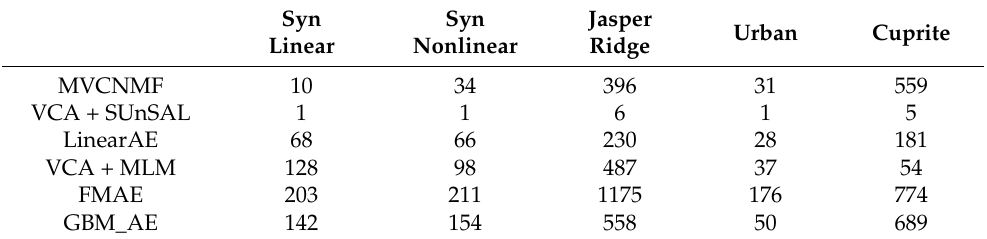
Table 7. The average running time in second (s) for all methods on each dataset.